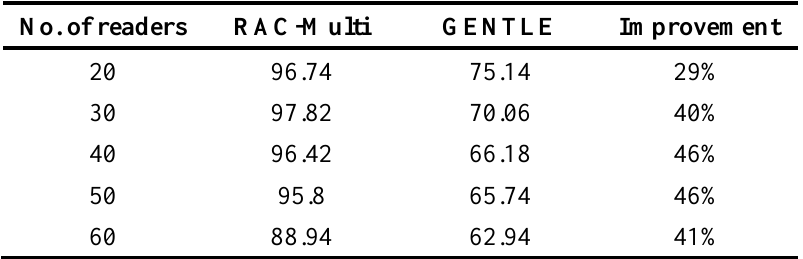
Table. 7 Average throughputs and